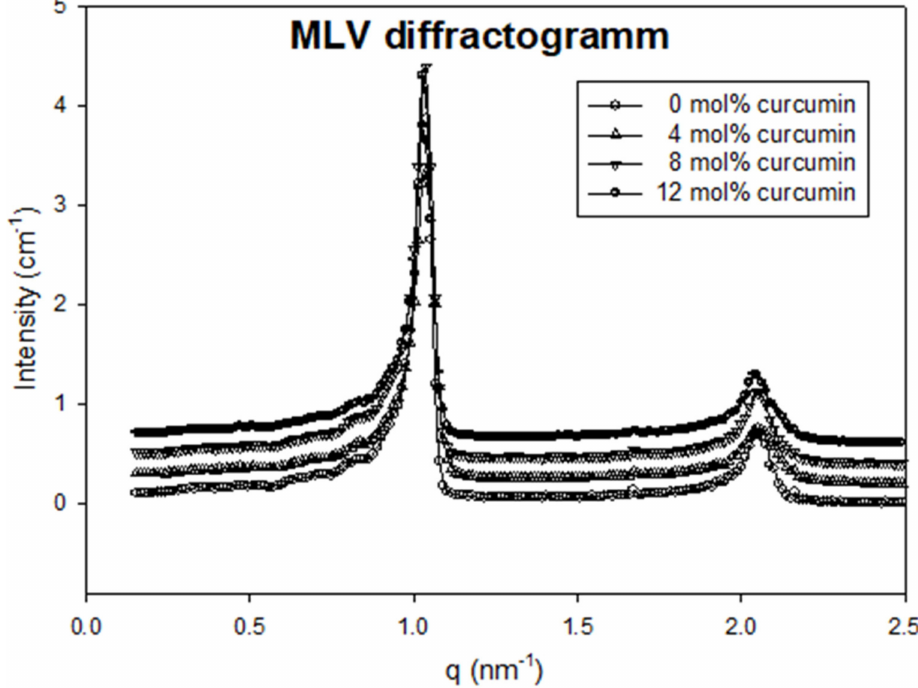
Figure 4. Di ff ractograms of multilamellar vesicles containing various amounts of curcumin. Scales were o ff set for a better